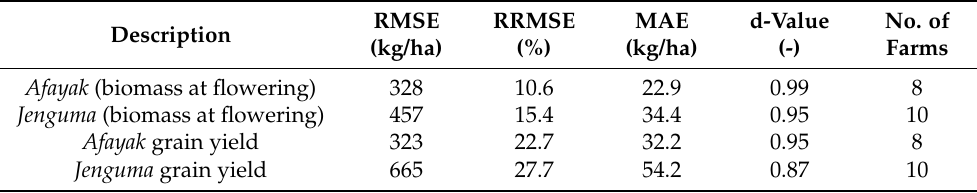
Table 3. Calibration statistics at flowering and maturity for the two soybean varieties.